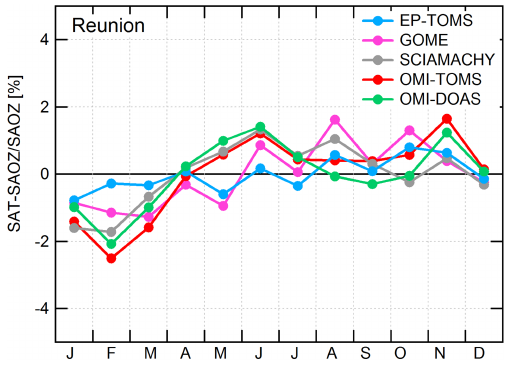
Figure 6. Same as Fig. 4 but for